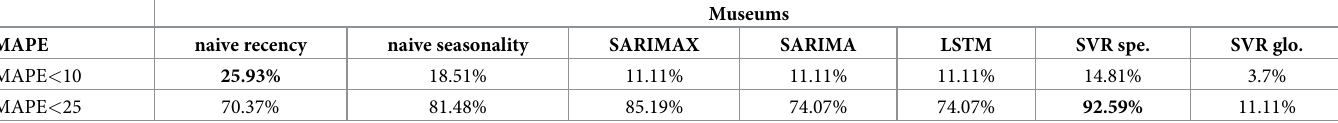
Table 5. Baseline results for 76 national parks in U.S. (outdoors). The values in the table represent the percentage of attractions with MAPE in each specified range. Parks MAPE naive recency naive seasonality SARIMAX SARIMA LSTM SVR spe. SVR glo. MAPE < 10 6.58% 42.11% 13.16% 7.89% 23.68% 22.37% 5.26% MAPE < 25 56.58% 82.89% 69.74% 39.47% 84.21% 94.74% 18.42%